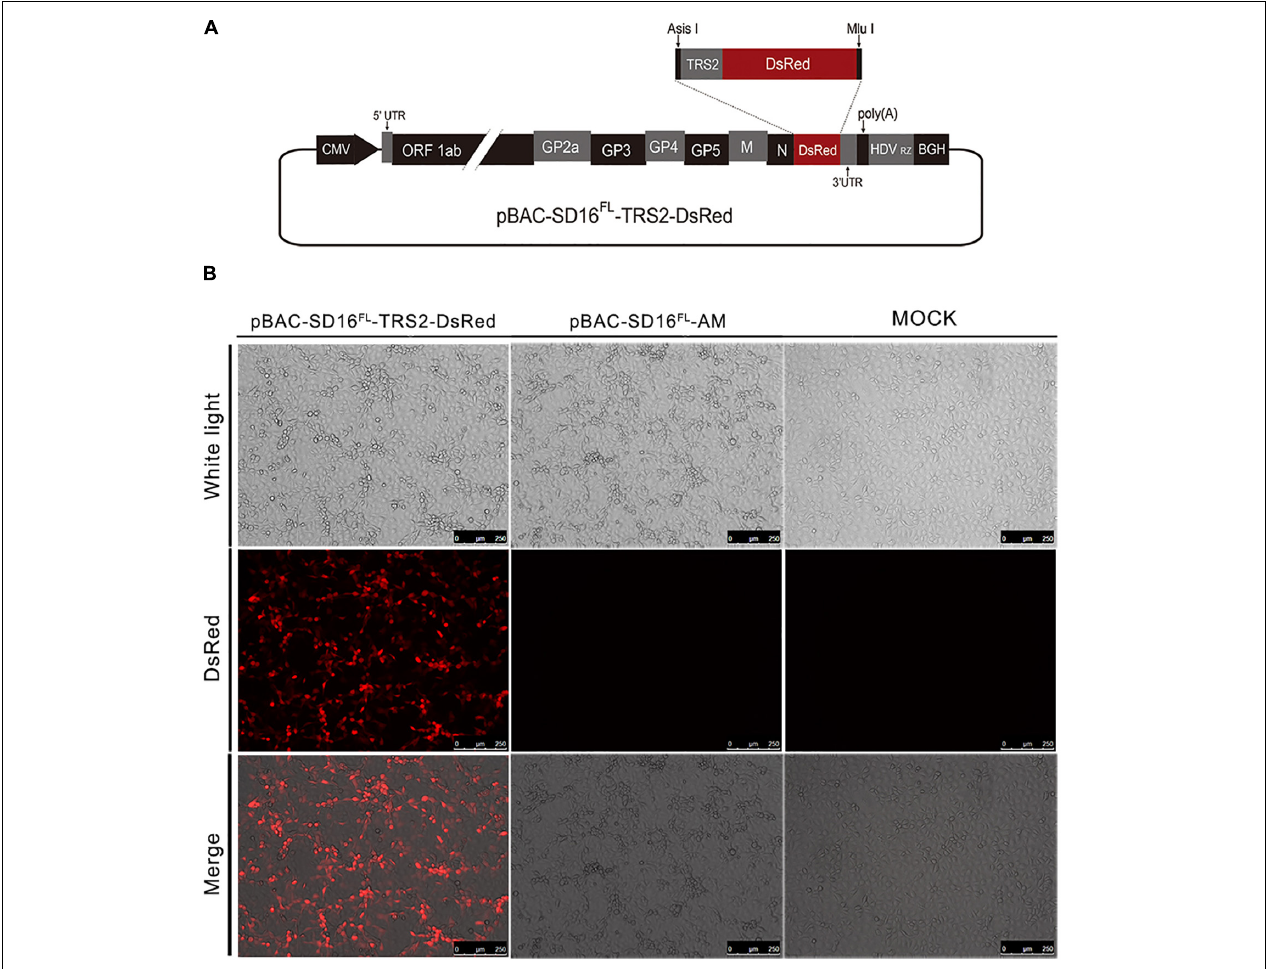
FIGURE 1 | Plasmid construction of pBAC-SD16 FL -TRS2-DsRed and DsRed expression in MARC-145 cells after transfection. (A) The DsRed gene was flanked by the transcription regulatory sequence 2 (TRS2) at the 5 (cid:48) end was inserted into plasmid pBAC-SD16 FL -AM to produce plasmid pBAC-SD16 FL -TRS2- DsRed using sites of Asi SI and Mlu I; (B) MARC-145 cells transfected with pBAC-SD16 FL -TRS2-DsRed or pBAC-SD16 FL -AM in a 6-well plate, after 48 h post-transfection, the fluorescence pictures in the live cells were captured by fluorescence